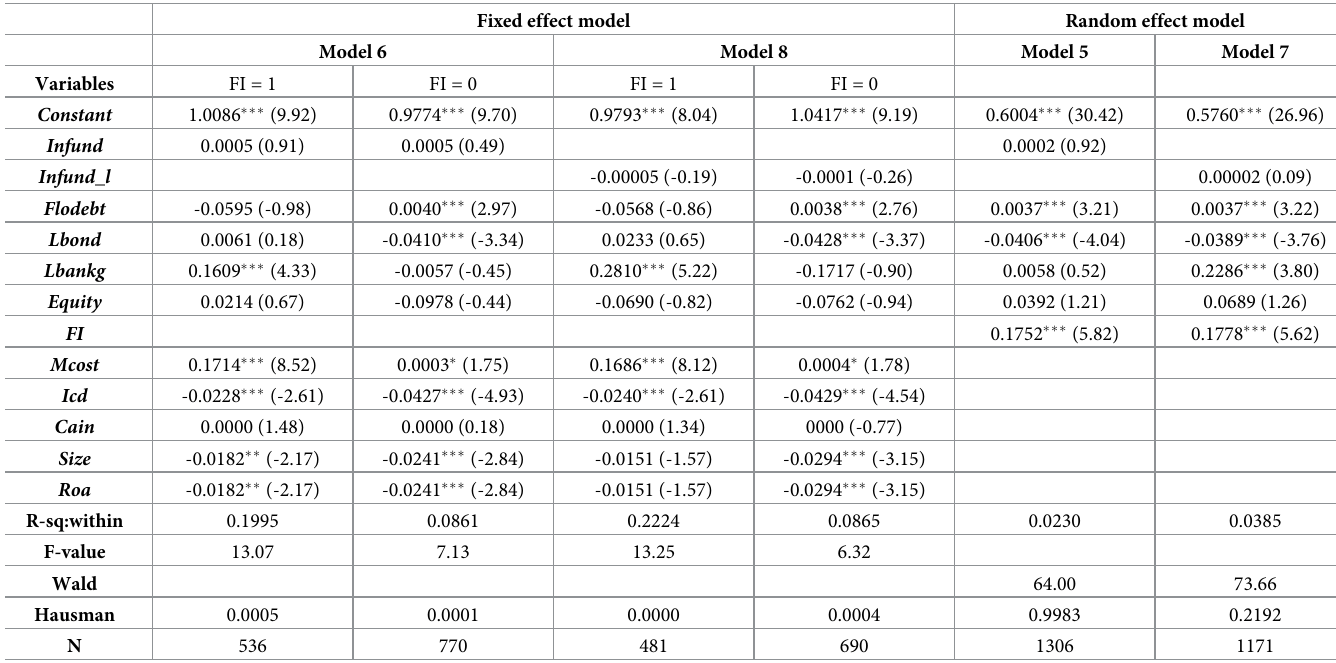
Table 10. Results of the panel regression